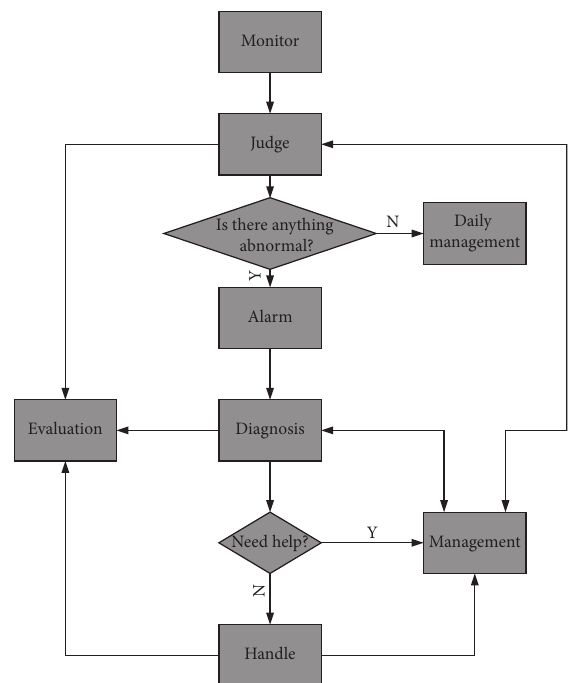
Figure 2: Flow chart of precontrol management of highway construction safety